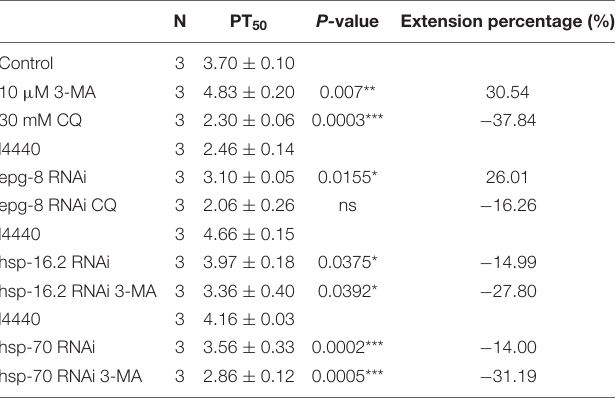
TABLE 2 | Paralysis assay in CL4176 strain